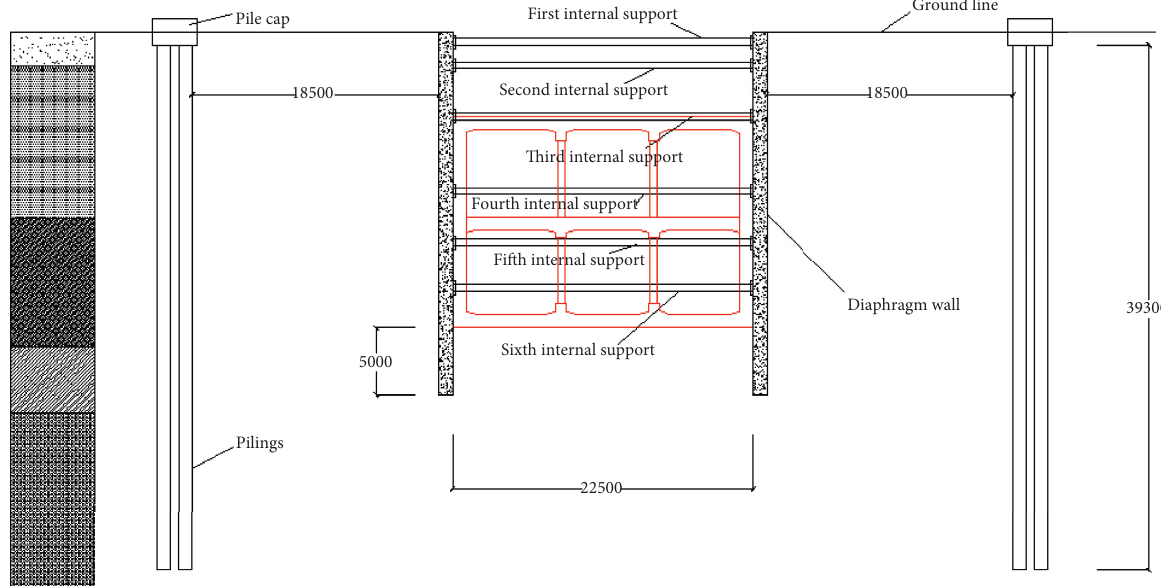
Figure 2: The section position relation between subway station and pile